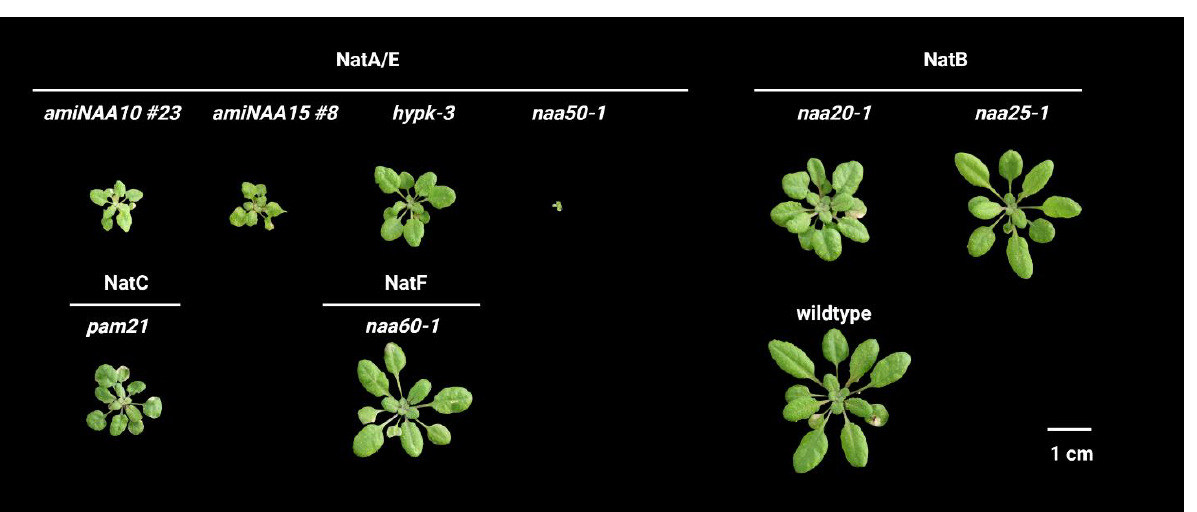
Figure 6. Phenotype of A. thaliana mutants impaired in different components of the NTA ma- chinery. Mutants impaired in Nat machinery components (amiNAA10 #23, amiNAA15 #8, hypk-3 = SALK_080671, naa20-1 = SALK_027687, naa25-1 = GK-819A05, pam21 (photosyntheis affected mutant21 = SALK_119000, naa60-1 = SALK_016406C, naa70 = SALK_072318) were grown on soil for four weeks under short-day conditions, except for the naa50 mutant (SAIL_1210_A02) which was germinated on ½ MS medium and transferred to soil after four weeks of growth. Photographs were taken by the authors and represent phenotypes of mutants previously described in independent studies cited in the main body text .